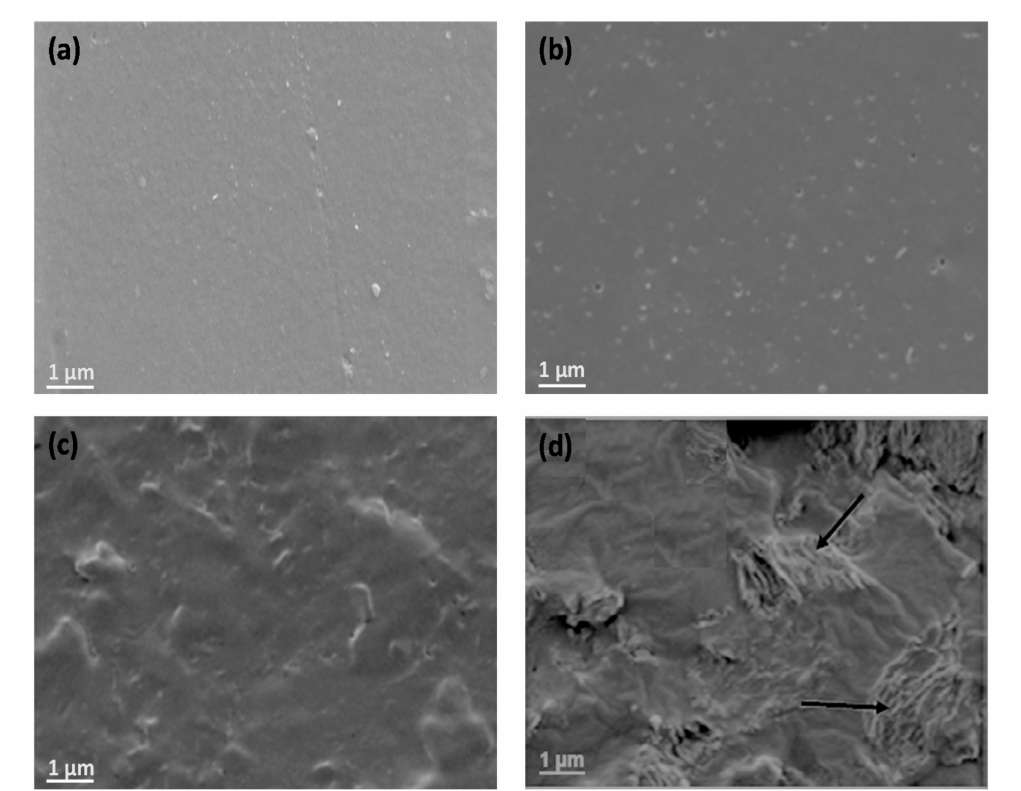
Figure 1. SEM images of PHBHHx ( a ) and the nanocomposites with 0.5 ( b ), 2.0 ( c ) and 5.0 ( d ) wt% graphene oxide (GO) content. The arrows point the GO sheets within the PHBHHx